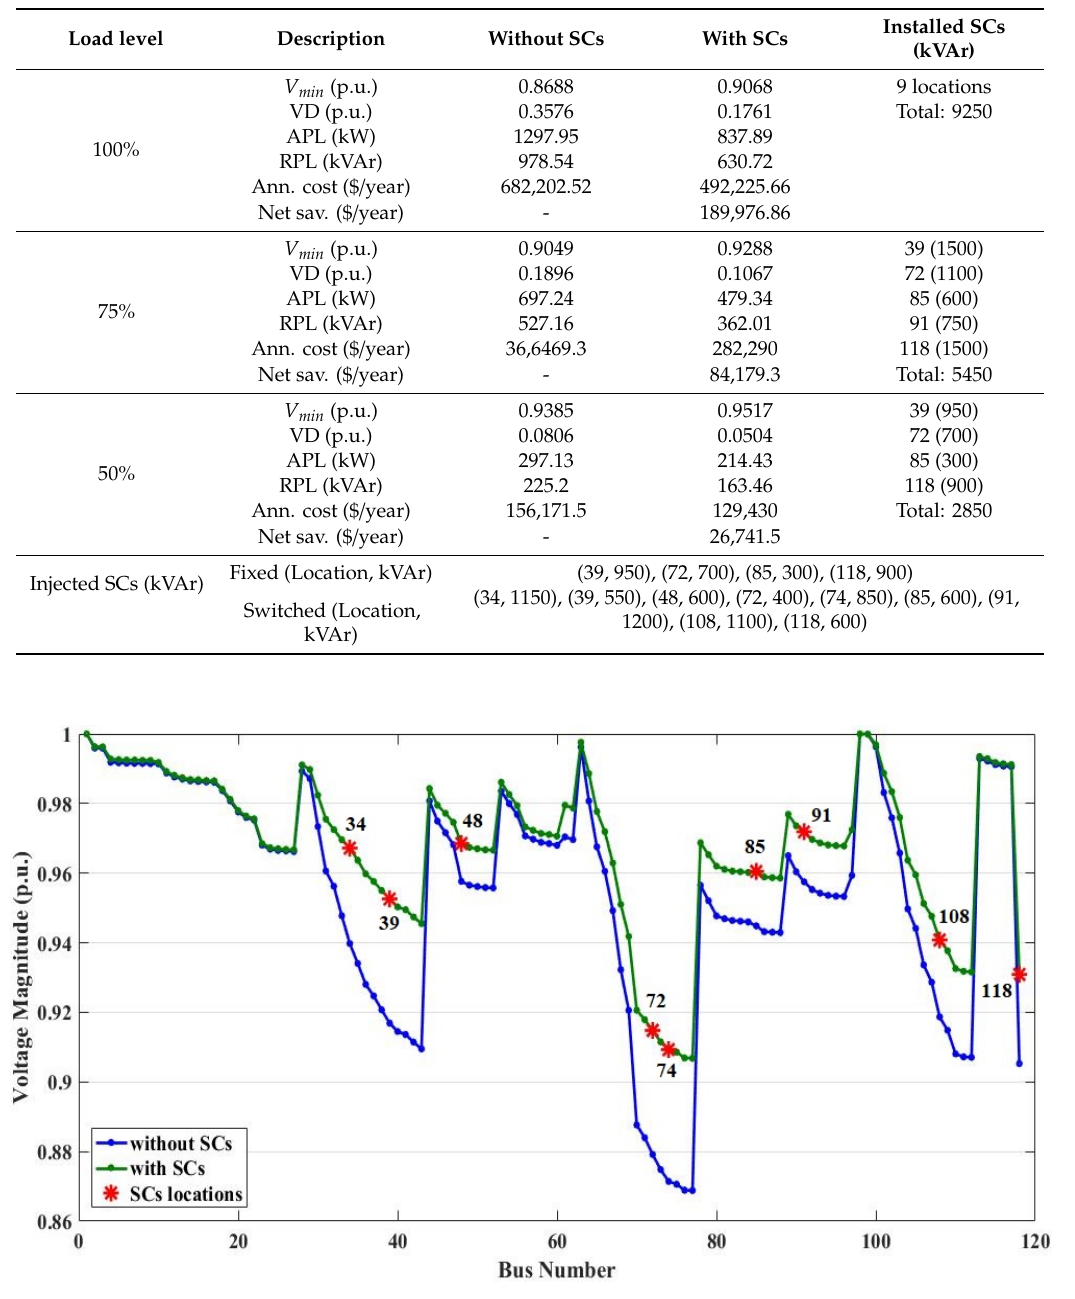
Table 16. Optimal results of PODESCA and SBDMT for the 118-bus system considering di ff erent load levels.